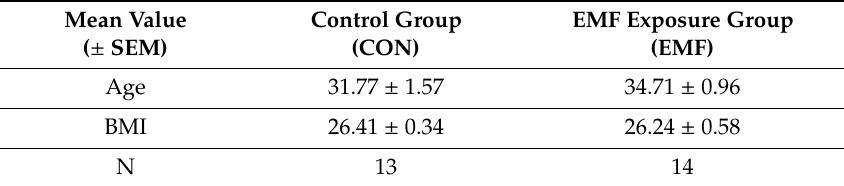
Table 2. Basic anthropometric properties of volunteers.